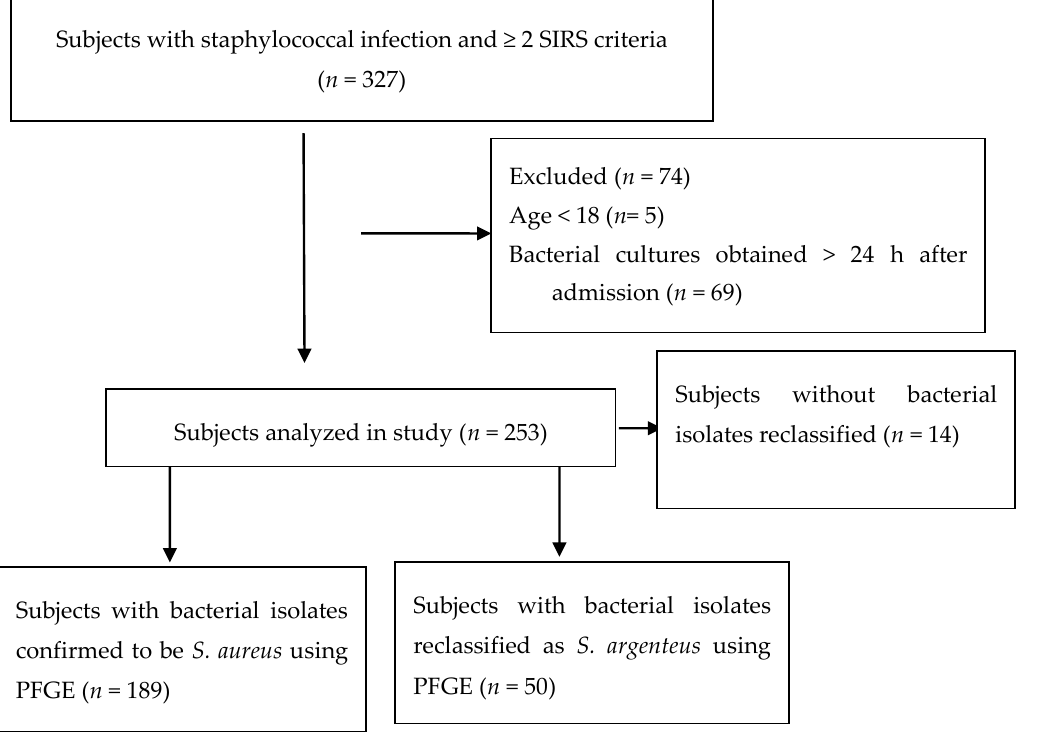
Figure 1. Number of patients included in the secondary analysis. Abbreviations: PFGE = Pulsed field gel electrophoresis.